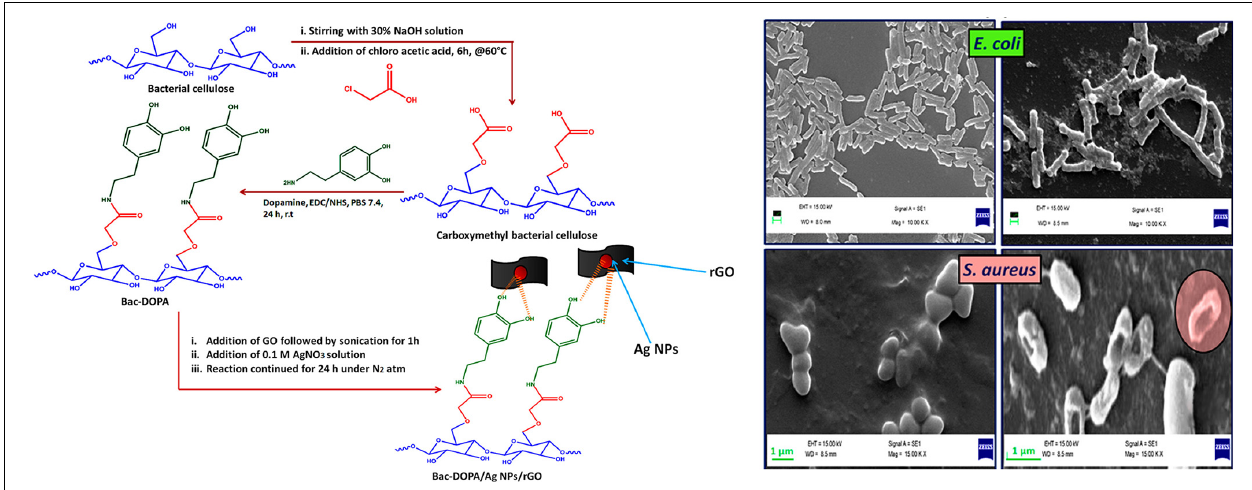
FIGURE 6 | Preparation process and antibacterial effect against E. coli and S. aureus of BC-DOPA/rGO/Ag NPs composite (Khamrai et al., 2019).